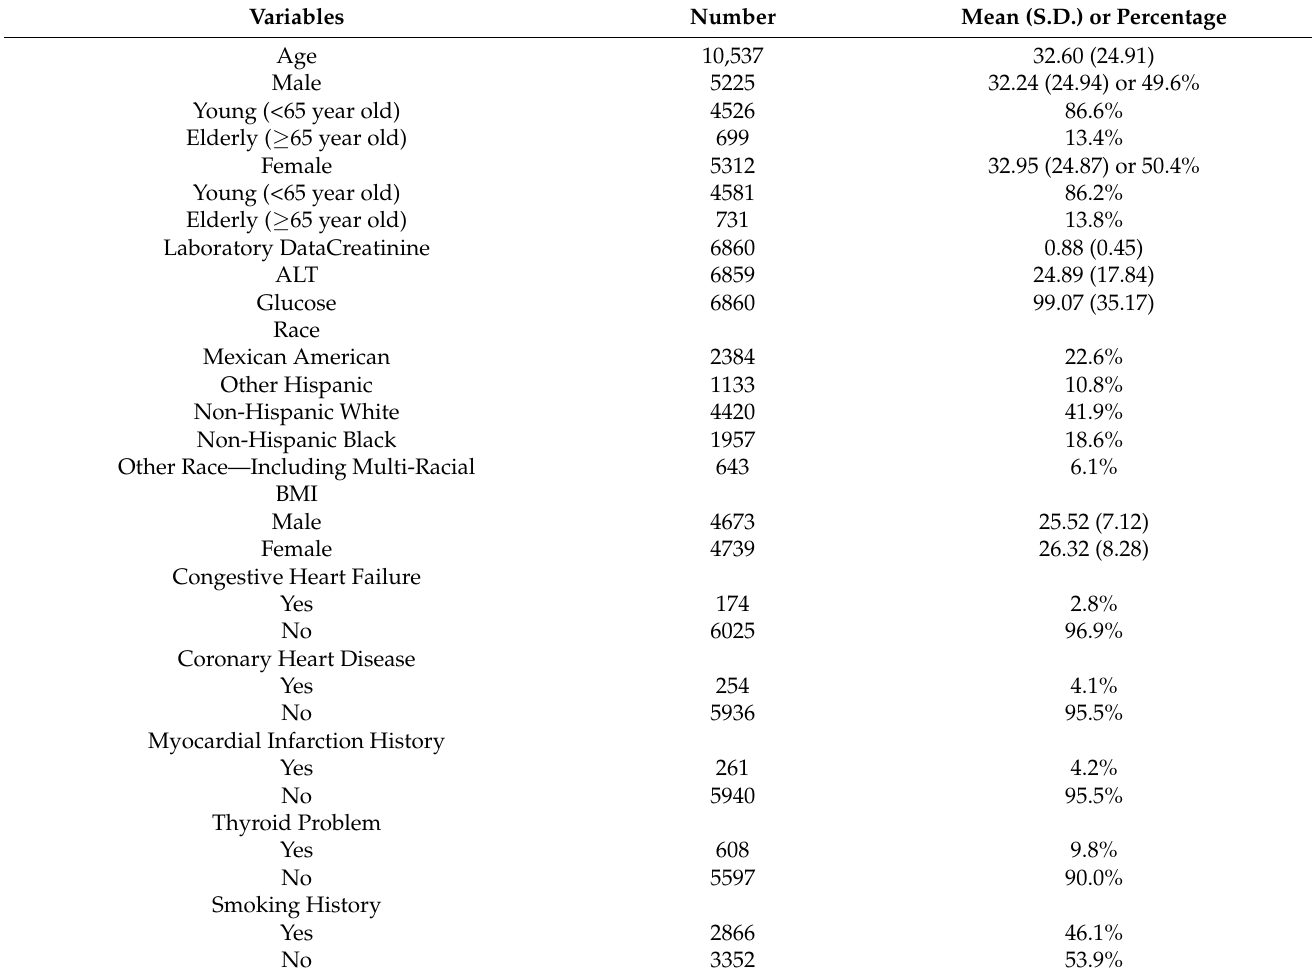
Table 1. Study sample